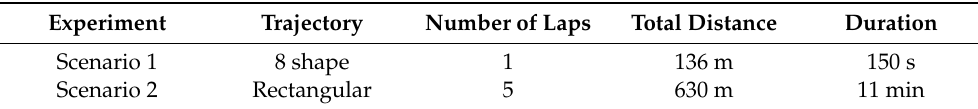
Table 3. Details of the experiments.